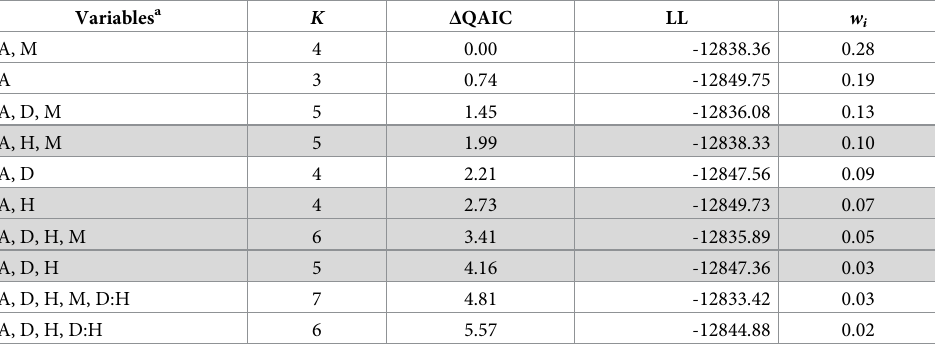
Table 6. Variables, number of parameters ( K ), delta Quasi-AIC ( Δ QAIC), log-likelihood (LL), and QAIC weights for all-taxa top model set. Shaded rows represent models with uninformative parameters. Variables